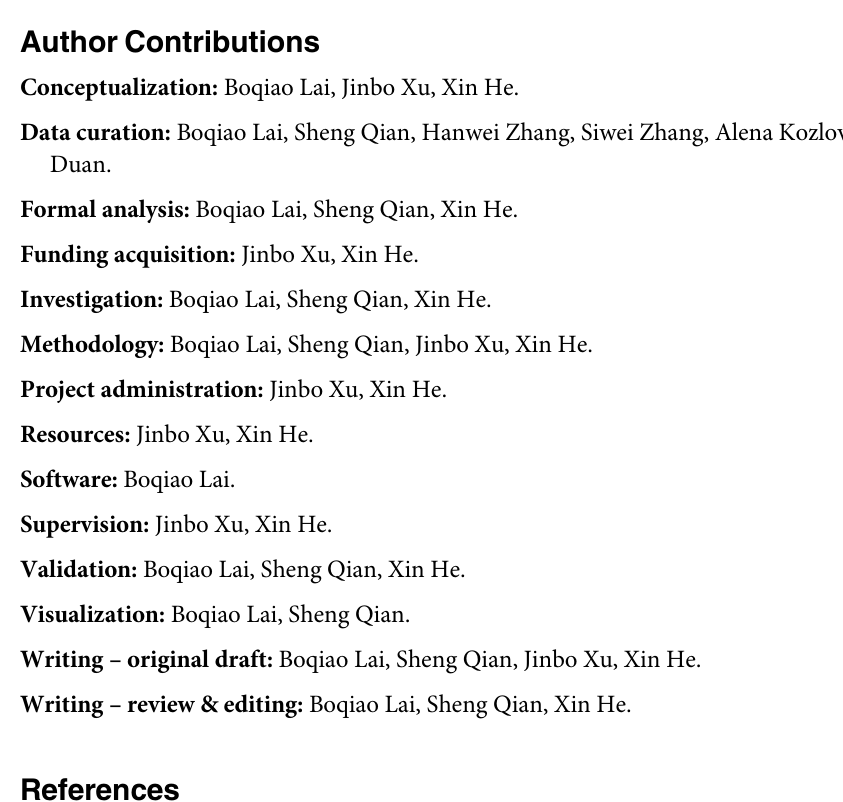
MetaChrom predicted functional variants across 31 cell types. Fig K . Comparison of methods in predicting ASC variants (A) Zoomed-in Precision-Recall (PR) curve with Recall in [0,0.2] and Precision in [0,0.25]. (B) Number of ASC variants in top K prioritized variants. Fig L . The observed allelic imbalance vs. MetaChrom predicted effects on chromatin accessibility of ASC variants in NPC neurons. Fig M . Likely causal variant rs1080500 and its MetaChrom func- tional annotations. The candidate SNP rs1080500 is chosen as the reference variant for com- puting LD and it is highlighted by the red dash line in each panel. The upper panel shows the significance of GWAS SNPs, LD between SNPs and genes in this region. The next panel shows credible set SNPs identified by fine-mapping (PIPs) in this region. The remaining panels show MetaChrom scores in four cell types, two in the fetal stage (FB_OCR and Glut) and two in the adult stage (VLPFC neuron and OFC neuron). Fig N . Baseline CNN model Architecture. S1 Table. Table A . Cell type information. Table B . Creditable SNPs set. Table C . GWAS Can- didate